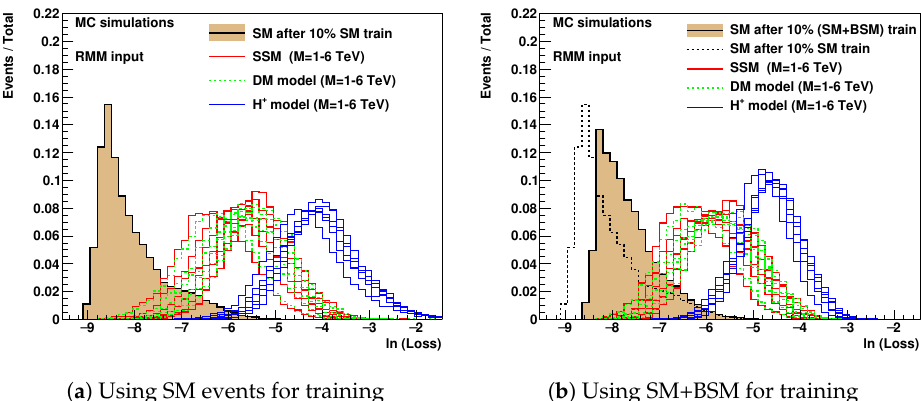
Figure 2. Distributions of the loss values for the trained autoencoder with ( a ) 10% of SM events and ( b ) 10% of SM and BSM models. The BSM models used in training had 1000 events for each mass point in the range 1–6 TeV. The BSM models are shown for Z (cid:48) / W (cid:48) heavy bosons using the same mass (shown with different lines of the same color). The distributions are normalized to 1. The larger the mass of the resonance, the further away the line is from the SM distribution. For the comparison, the black dashed line shows the SM events when using 10% of the event samples without BSM